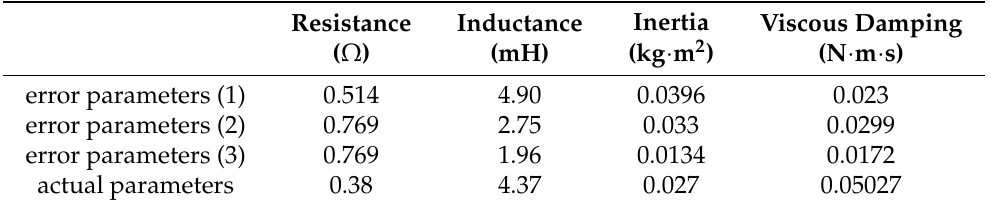
Table 8. Three groups of error motor parameters and motor actual